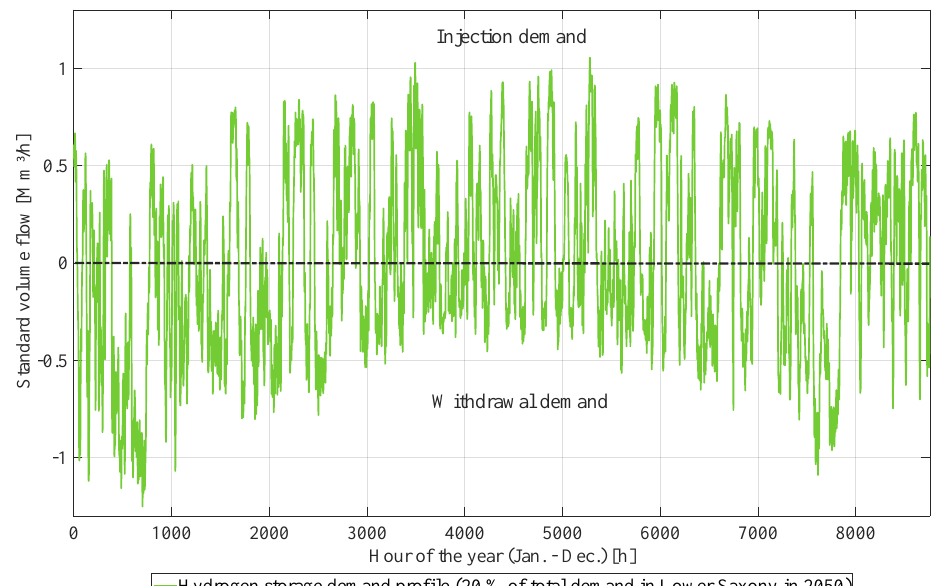
Figure 6. Injection and withdrawal as volume flow demand over the course of a calendar